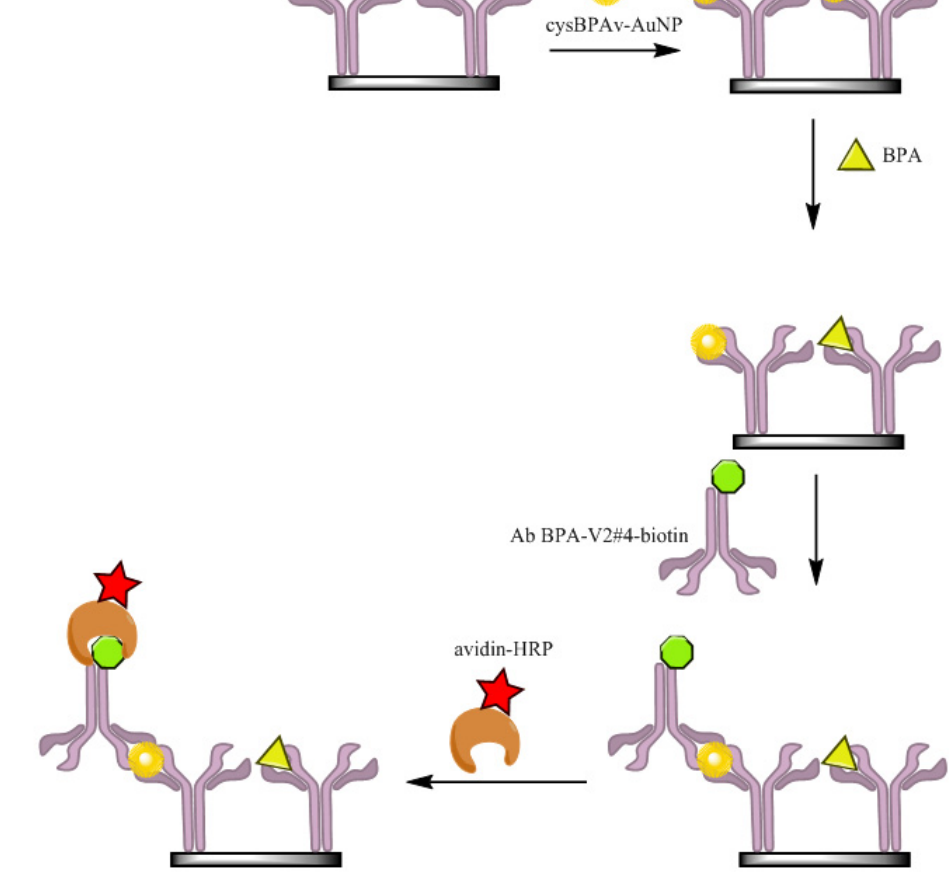
Figure 1. The configuration of the displacement-ELISA (d-ELISA). Ab BPA-V2#4-biotin: anti-BPA antibody–biotin (green) conjugate; Avidin-HRP: avidin (brown)-horseradish peroxidase (red); cysBPAv-AuNP: thiolated bisphenol A (BPA)-functionalized gold nanoparticles (yellow). 2.6. Percent Relative Saturation (%RS)